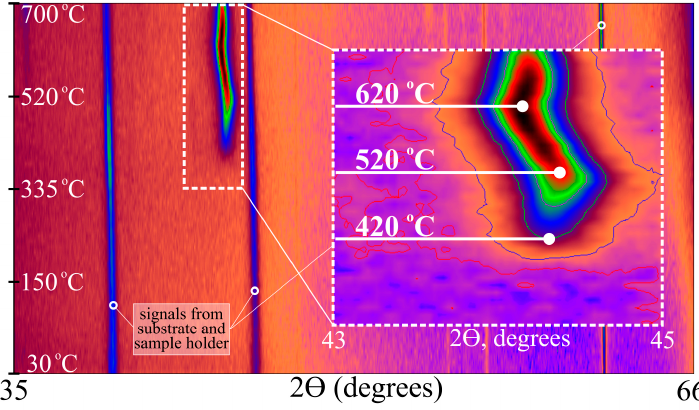
Figure 4. TDX data of Fe 72.5 Nb 1.5 Mo 2 Cu 1.1 Si 14.2 B 8.7 films with thicknesses of 150 nm.